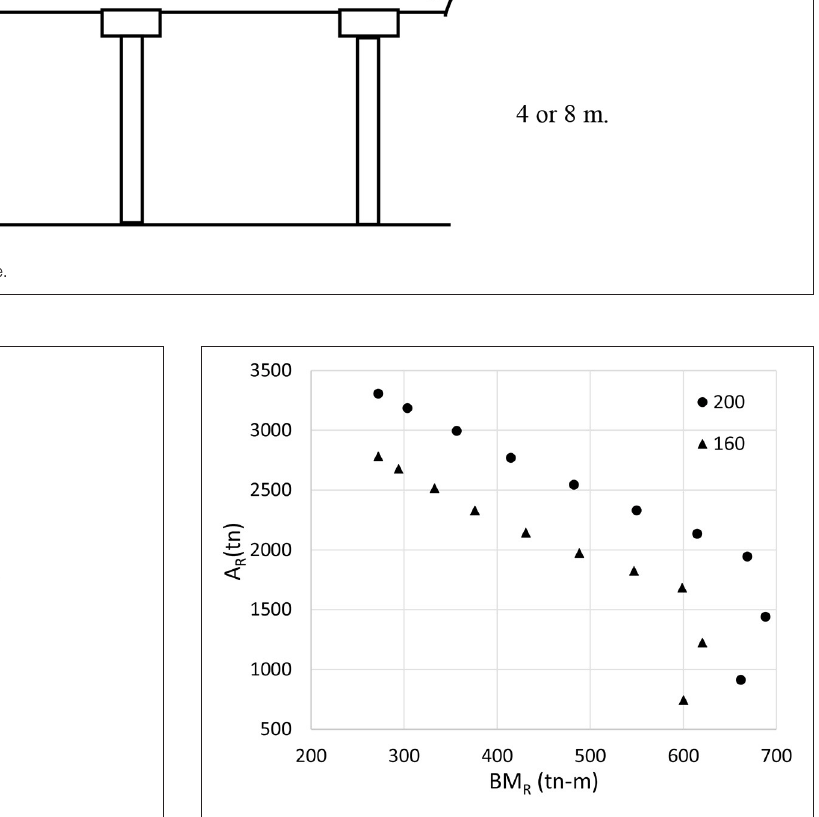
FIGURE 5 | Interaction diagram for critical pier for f ′ c = 160 and 200 Kg/cm 2 .